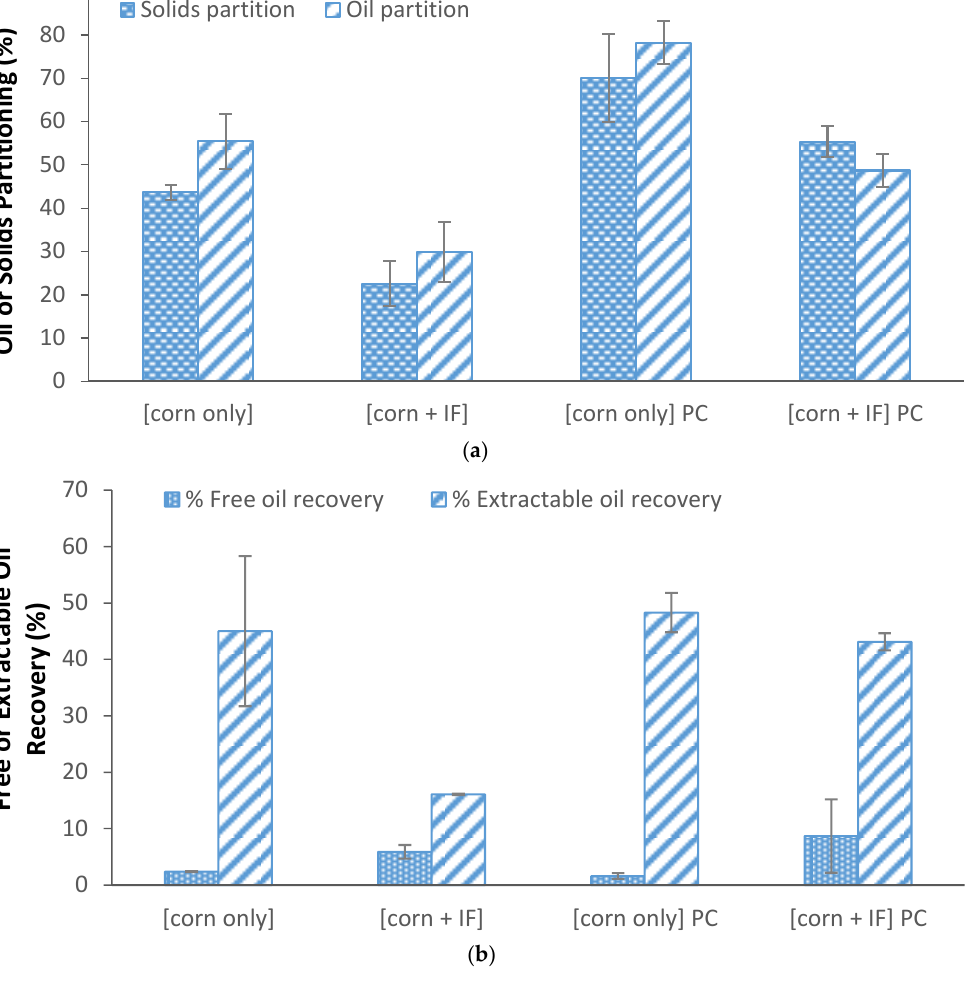
Figure 8. Effect of addition of IF and enzymes (pectinase and cellulase, PC) in corn fermentation on ( a ) solids and oil partition in thin stillage, and ( b ) %free and % extractable oil recovery from thin stillage. Error bars indicate standard deviation between at least duplicate runs.